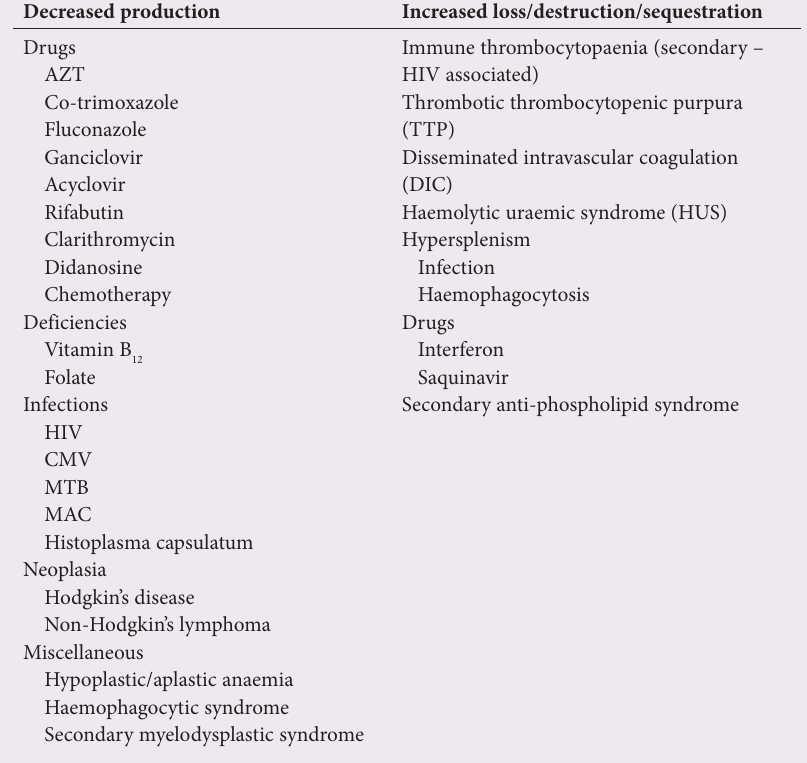
Table 2. Thrombocytopaenia and HIV